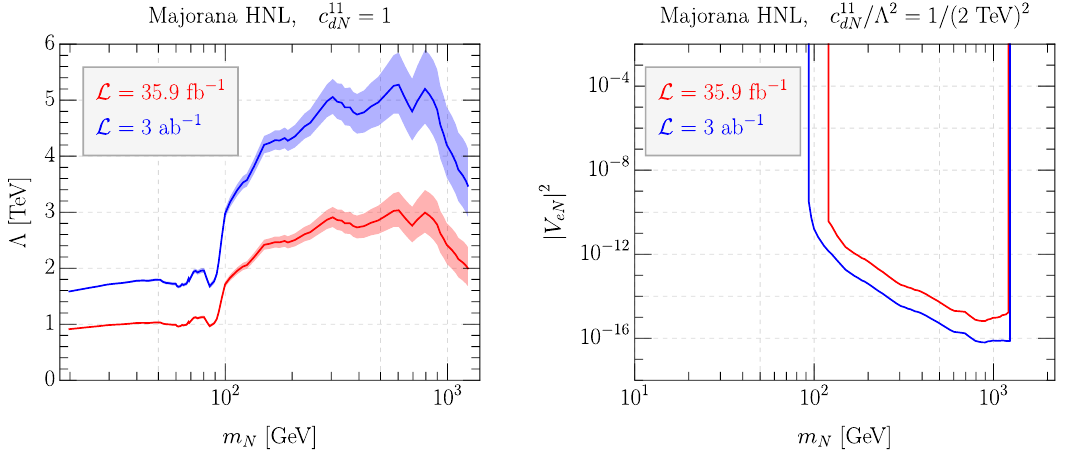
Figure 9 . To the left: plot showing our estimate for the current limit on Λ for the operator O dN from the reinterpretation of the CMS same-sign dilepton search [27], for electron final state. The red line is the current limit, the blue line is our estimate for a future luminosity of L = 3 ab − 1 , based on this data. The coloured bands are a rough estimate of the error of our reinterpretation procedure. To the right: range of m N and | V eN | 2 that could be probed for Λ = 2 TeV by this search (see text for